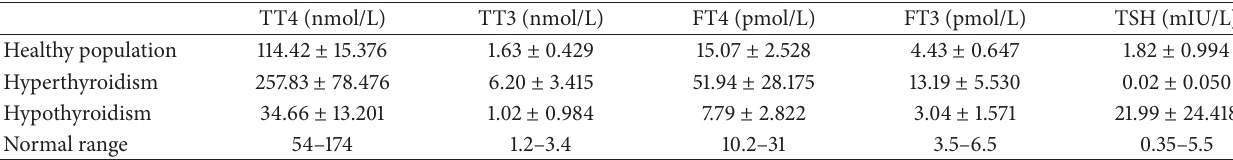
Table 2: TT4, TT3, FT4, FT3, and TSH of three groups.